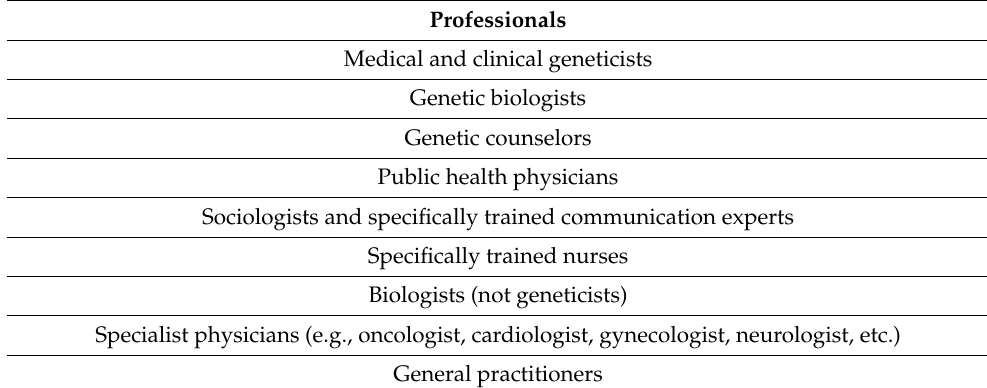
Table 6. Items selected in the category “Professionals to involve in citizens’ educational initiatives”, listed by decreasing mean scores from the Delphi